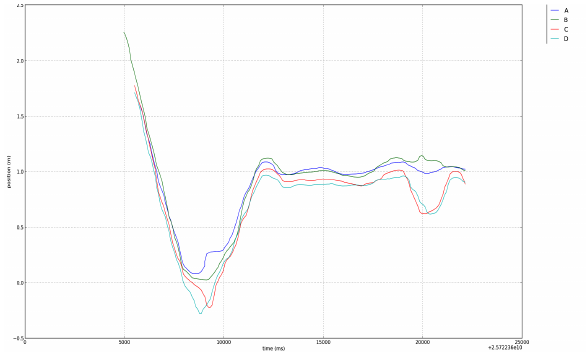
Figure 8: Variation of the trajectories along the X axis